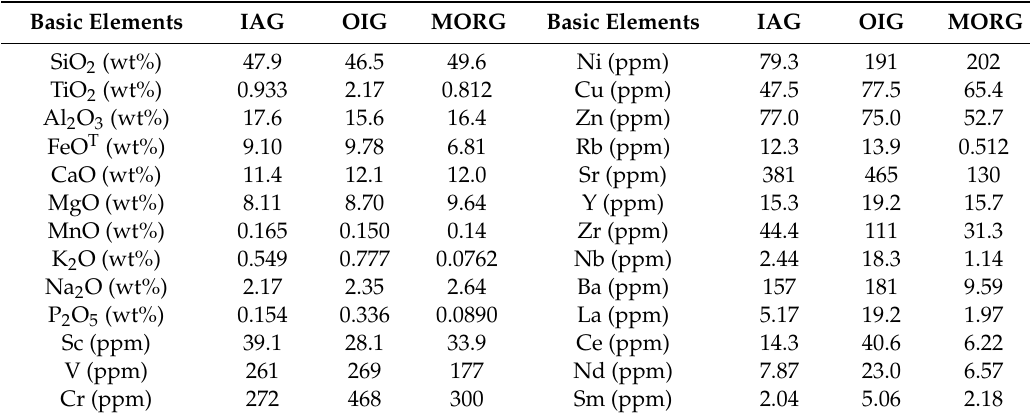
Table 1. Mean element contents of island-arc gabbroic rocks (IAG), ocean-island gabbroic rocks (OIG), and mid-oceanic ridge gabbroic rocks (MORG) samples.